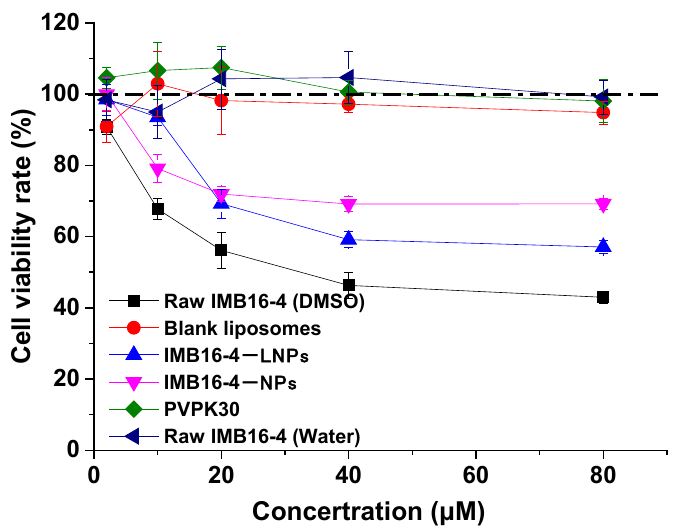
Figure 5. Cell viability of LX-2 cells treated with raw IMB16-4, blank liposomes, and IMB16-4 − LNPs for 24 h, respectively. All samples were diluted with DMEM/GlutaMAX I without FBS. The data are presented as mean ± SD of at least triplicate determinations.